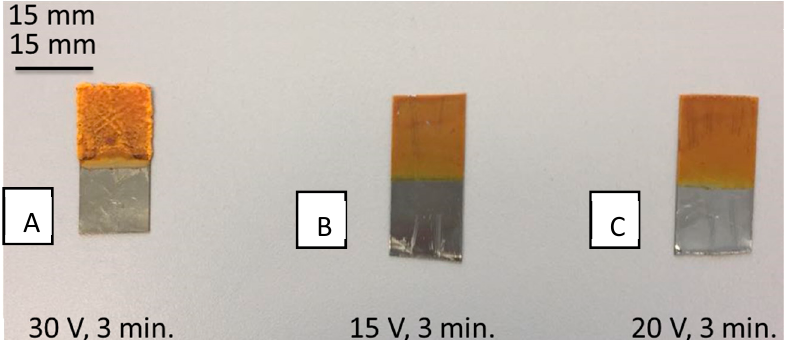
Figure 4. Digital camera images for the chitosan / curcumin composite coatings on 316L stainless steel (SS) produced at: ( A ) 30 V and 30 minutes, ( B ) 15V and 3 minutes, and ( C ) 20 V and 3 minutes by keeping the inter-electrode distance at 10 mm.